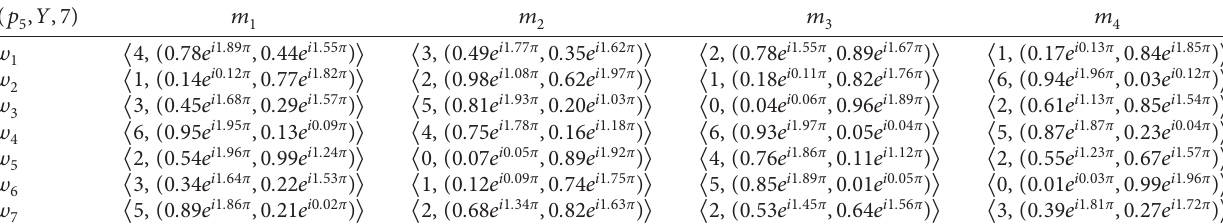
Table 20: Tabular representation of C